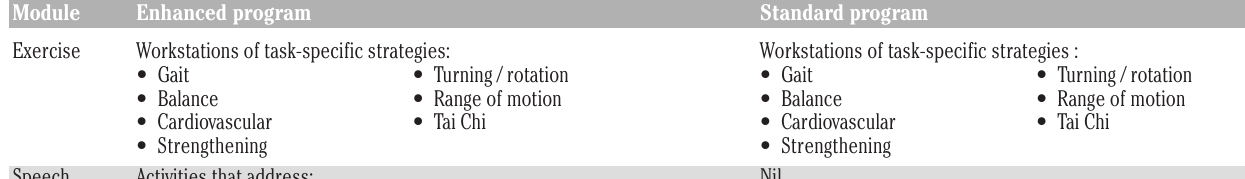
Table 1. Enhanced (intervention) and standard (control) group therapy programs.